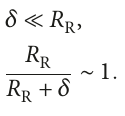
modi fi ed model based on four fl ux of radiation (FFM), whose equations are based on a cylindrical geometry, to mathemat- ically represent the radiation fi eld in a stirred annular photo- reactor. This model is coupled to a reaction rate model representing the benzyl alcohol oxidation. The FFM evalu- ates the incident radiation in each point of the reaction